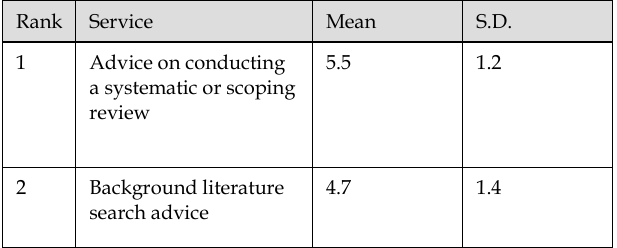
Table 2 Planning stage services ranked by perceived